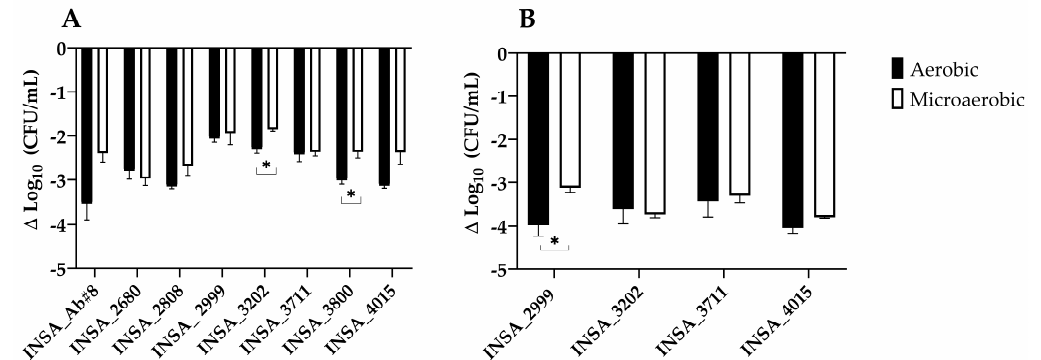
Figure 7. Adhesion ( A ) and invasion ( B ) of eight Arcobacter butzleri isolates to Caco-2 cells when grown under aerobic or microaerobic conditions. Strains not invading Caco-2 cells are not shown in the graphic. Results were analysed using Student’s t -test. The data shown represent the mean ± standard error of the means of at least three independent results. * p <